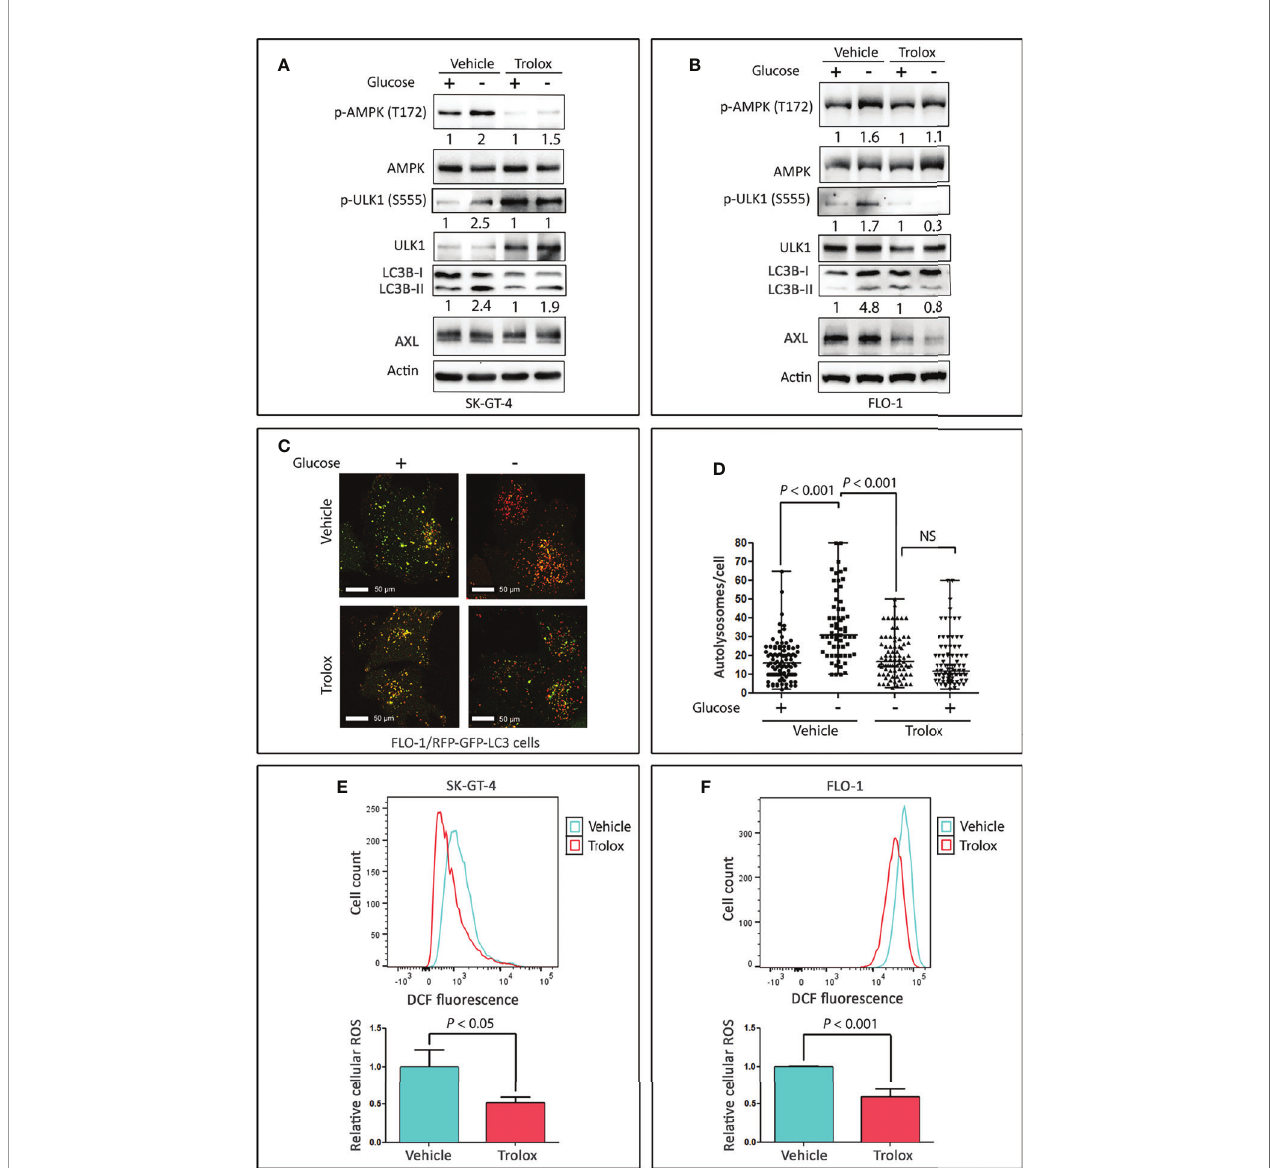
FIGURE 3 | Cellular ROS mediate activation of AMPK and autophagy in EAC cells. Western blot analysis of p-AMPK (T172), AMPK, p-ULK1 (S555), ULK1, LC3B, and AXL proteins in whole cell lysates from SK-GT-4 cells (A) and FLO-1 cells (B) following treatment with vehicle or 100 µM Trolox, a vitamin E analog and ROS scavenger, in the presence or absence of glucose for 4 h. FLO-1 cells stably expressing mRFP-GFP tandem fl uorescent-tagged LC3 reporter (tfLC3) were cultured in the presence or absence of glucose and treated with vehicle or 100 µM Trolox for 4 h to induce autophagy. (C) Representative confocal images (60x) of live cells depicting autophagosomes (green puncta) and autolysosomes (red puncta). Quanti fi cation of total number of autolysosomes per cell. (D) Data are shown as median ± SD. Cellular ROS levels in SK-GT-4 cells (E) and FLO-1 cells (F) were evaluated by DCFDA/H2DCFDA – Cellular Reactive Oxygen Species Detection Assay Kit